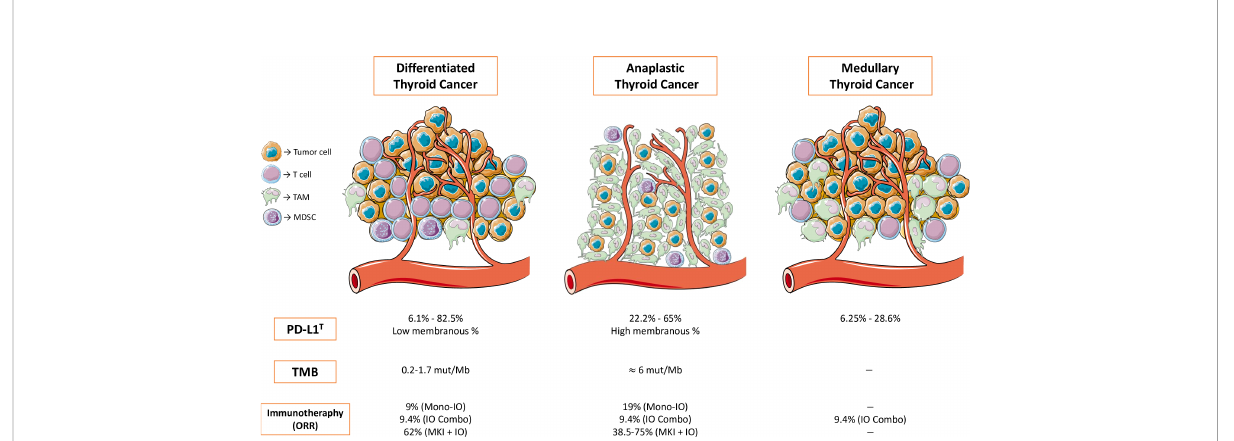
FIGURE 1 Summary of the most relevant information about biomarkers and immunotherapy ef fi cacy in clinical trials in thyroid neoplasms. TAM, tumor- associated macrophage; MDSC, myeloid-derived suppressor cell; PD-L1 T , PD-L1 membranous expression in tumor cells; TMB, tumor mutational burden; ORR, overall response rate; Mono-IO, immunotherapy monotherapy; IO-Combo, immunotherapy in combination with immunotherapy; MKI + IO, multikinase inhibitor in combination with